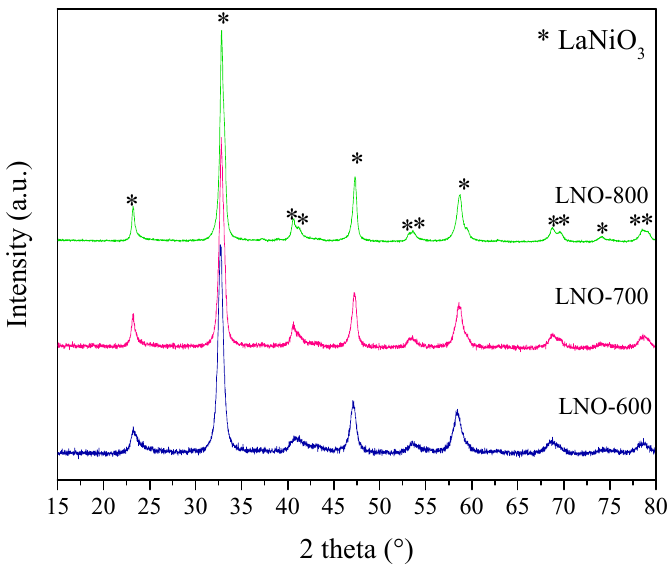
Figure 3. X-ray diffraction patterns of the LaNiO 3 samples calcined at different temperatures, where all the LaNiO 3 diffraction peaks were labeled as (*), based on the 01-088-0633 PDF